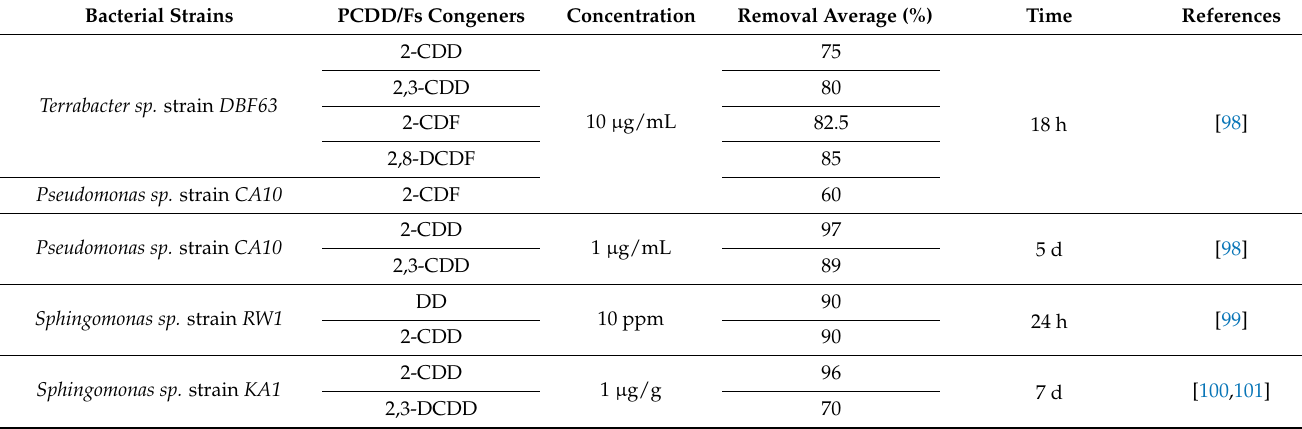
Table 4. Bacterial strains capable of biodegrading dioxins in a soil